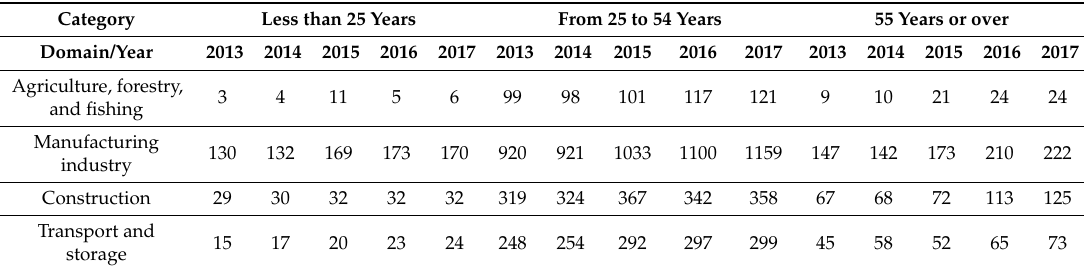
Table 4. The distribution of accidents in Romania by age